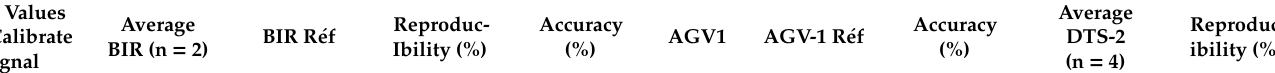
Table 1. Major and trace elements of